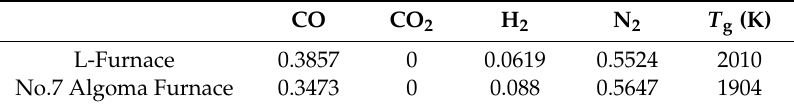
Table 5. Gas composition and temperature at the tuyere level of two reference BFs.